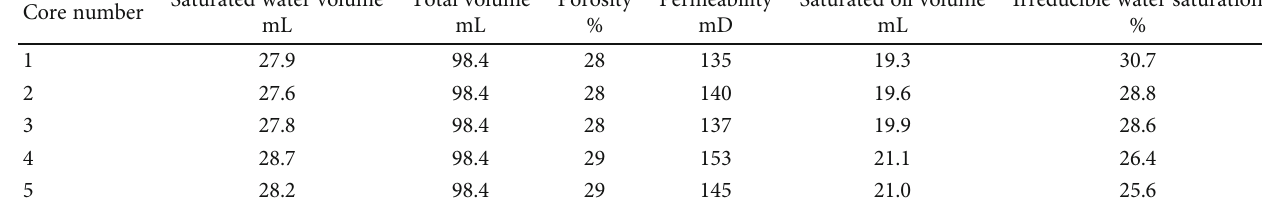
Table 1: Core data table.